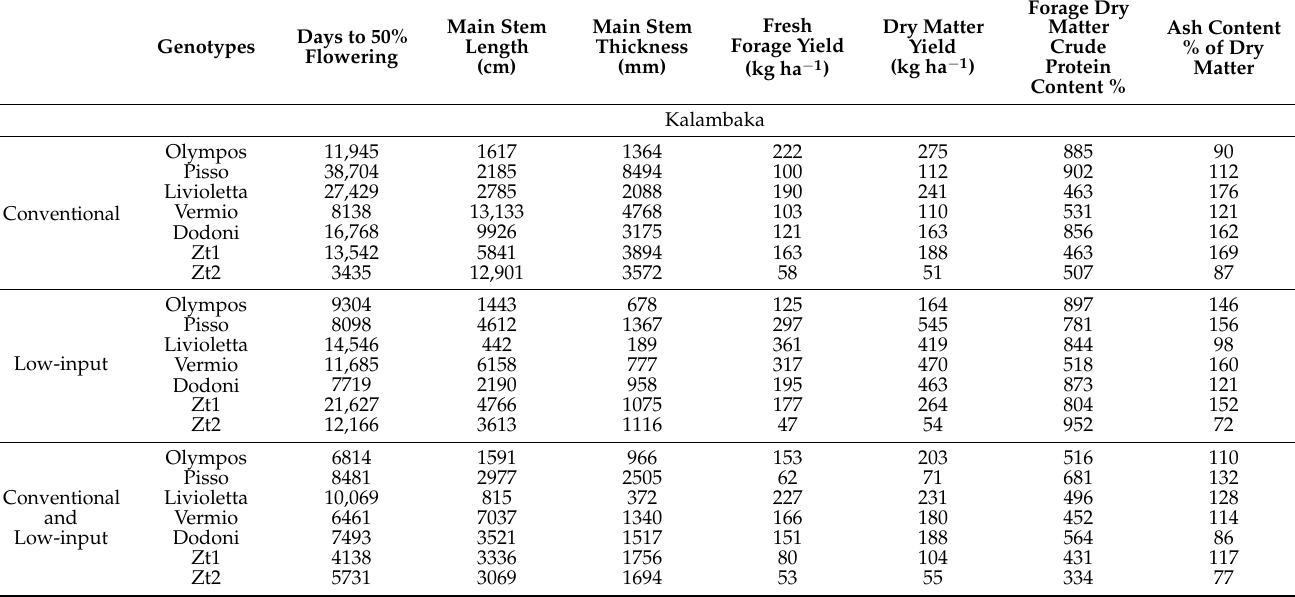
means are subtracted. A GGE biplot is a biplot that displays the GGE of a genotype through two-way environmental data. The GGE biplot methodology originates from the graphical analysis of multi-environment genotype trials (MET) data but is equally applicable to all other types of two-way